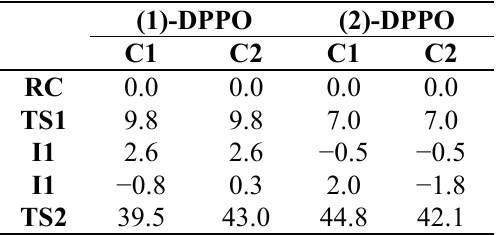
Table 2. Relative potential energies obtained at AM1 level related to reactant complex (RC) for the nucleophilic attack of Asp105 in Ser105Asp CALB on epoxide carbons C1 or C2 in two different orientations of substrate. Values are given in kcal·mol − 1 .